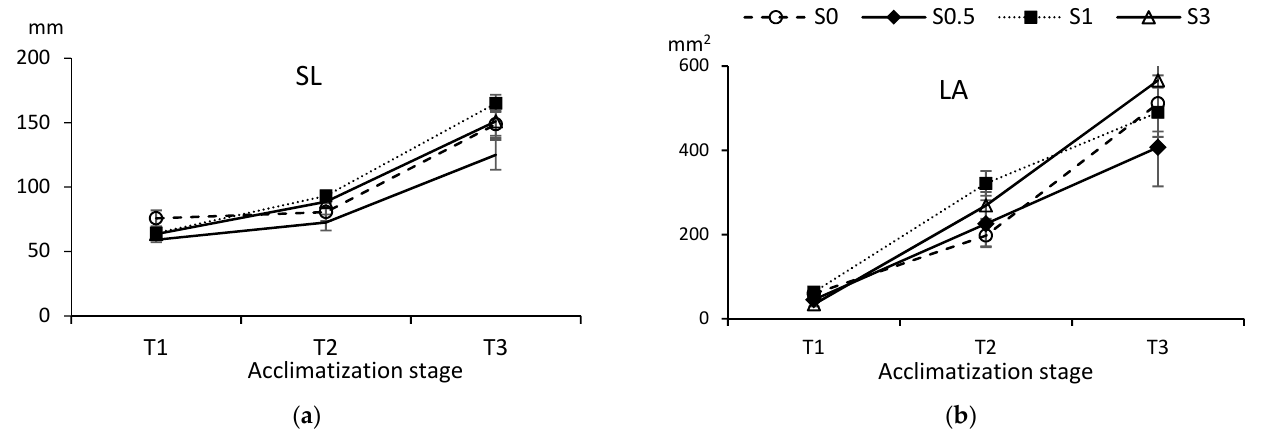
Figure 6. ( a ) Shoot length and ( b ) leaf area of willow plantlets during 3 stages of acclimatization (T1–T3). Rooted shoots cultured in RITA ® with different sucrose concentrations under PAM conditions were measured when transferred to the phytotron (T1), to the greenhouse 3 weeks later (T2), and 2 weeks afterwards (T3). Values are the mean ± standard error from two replicate trials each with 8 shoots per treatment. SL shoot length; LA leaf area of the largest leaf per explant; S0, S0.5, S1 and S3 indicate sucrose supplementation of 0, 0.5, 1 and 3%, respectively.